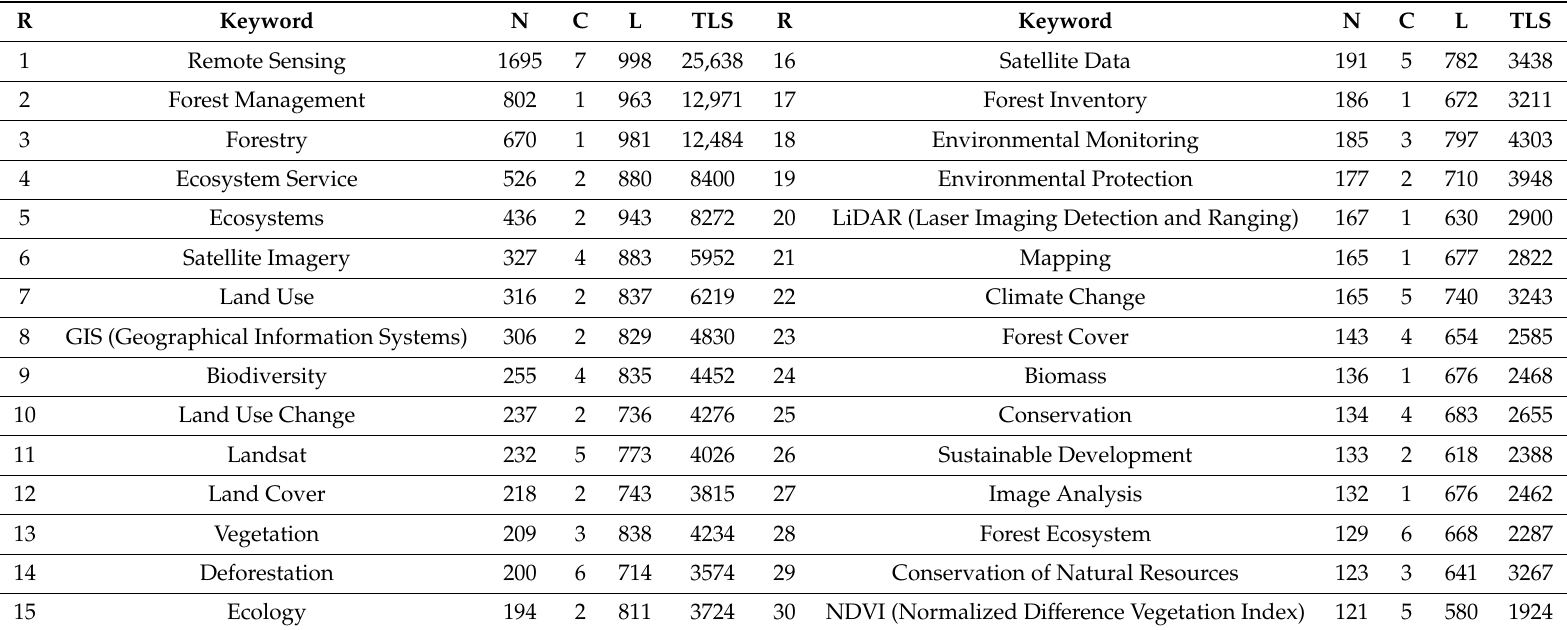
Table 2. Top 30 keywords